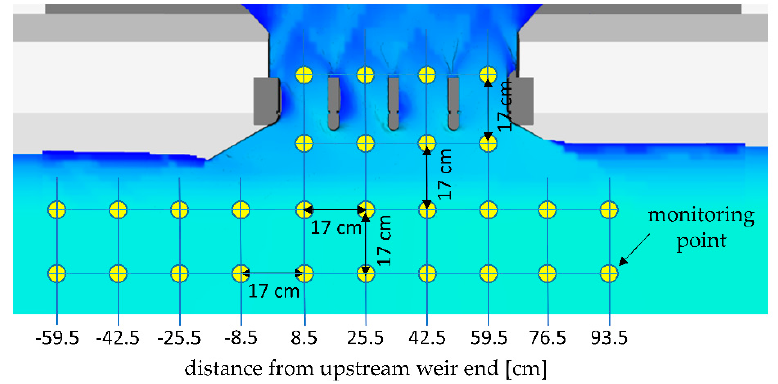
Figure 6. Arrangement of the 28 monitoring points at 10 cross-sections along the side weir; flow direction from left to right.